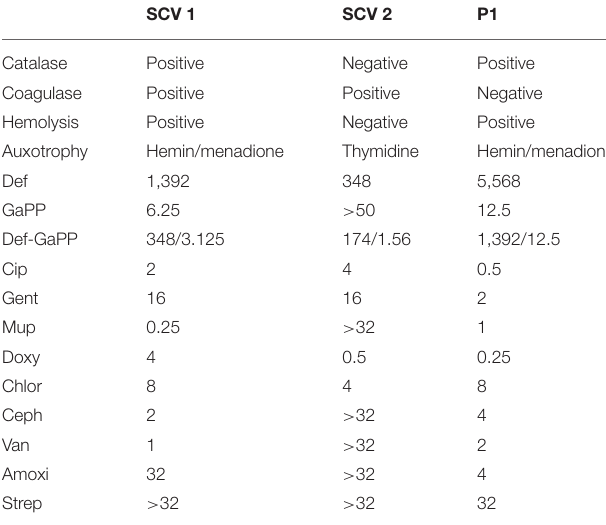
TABLE 1 | Characteristics of small colony variant SCV1, SCV2, and parent strain P1, including catalase, coagulase and hemolytic activity, auxotrophy type, as well as MICs (in µ g/ml) of deferiprone (Def), gallium-protoporphyrin (GaPP), the combination of both compounds, ciprofloxacin (Cip), gentamicin (Gent), mupirocin (Mup), doxycycline (Doxy), chloramphenicol (Chlor), cephalexin (Ceph), vancomycin (Van), amoxicillin (Amoxi), and streptomycin